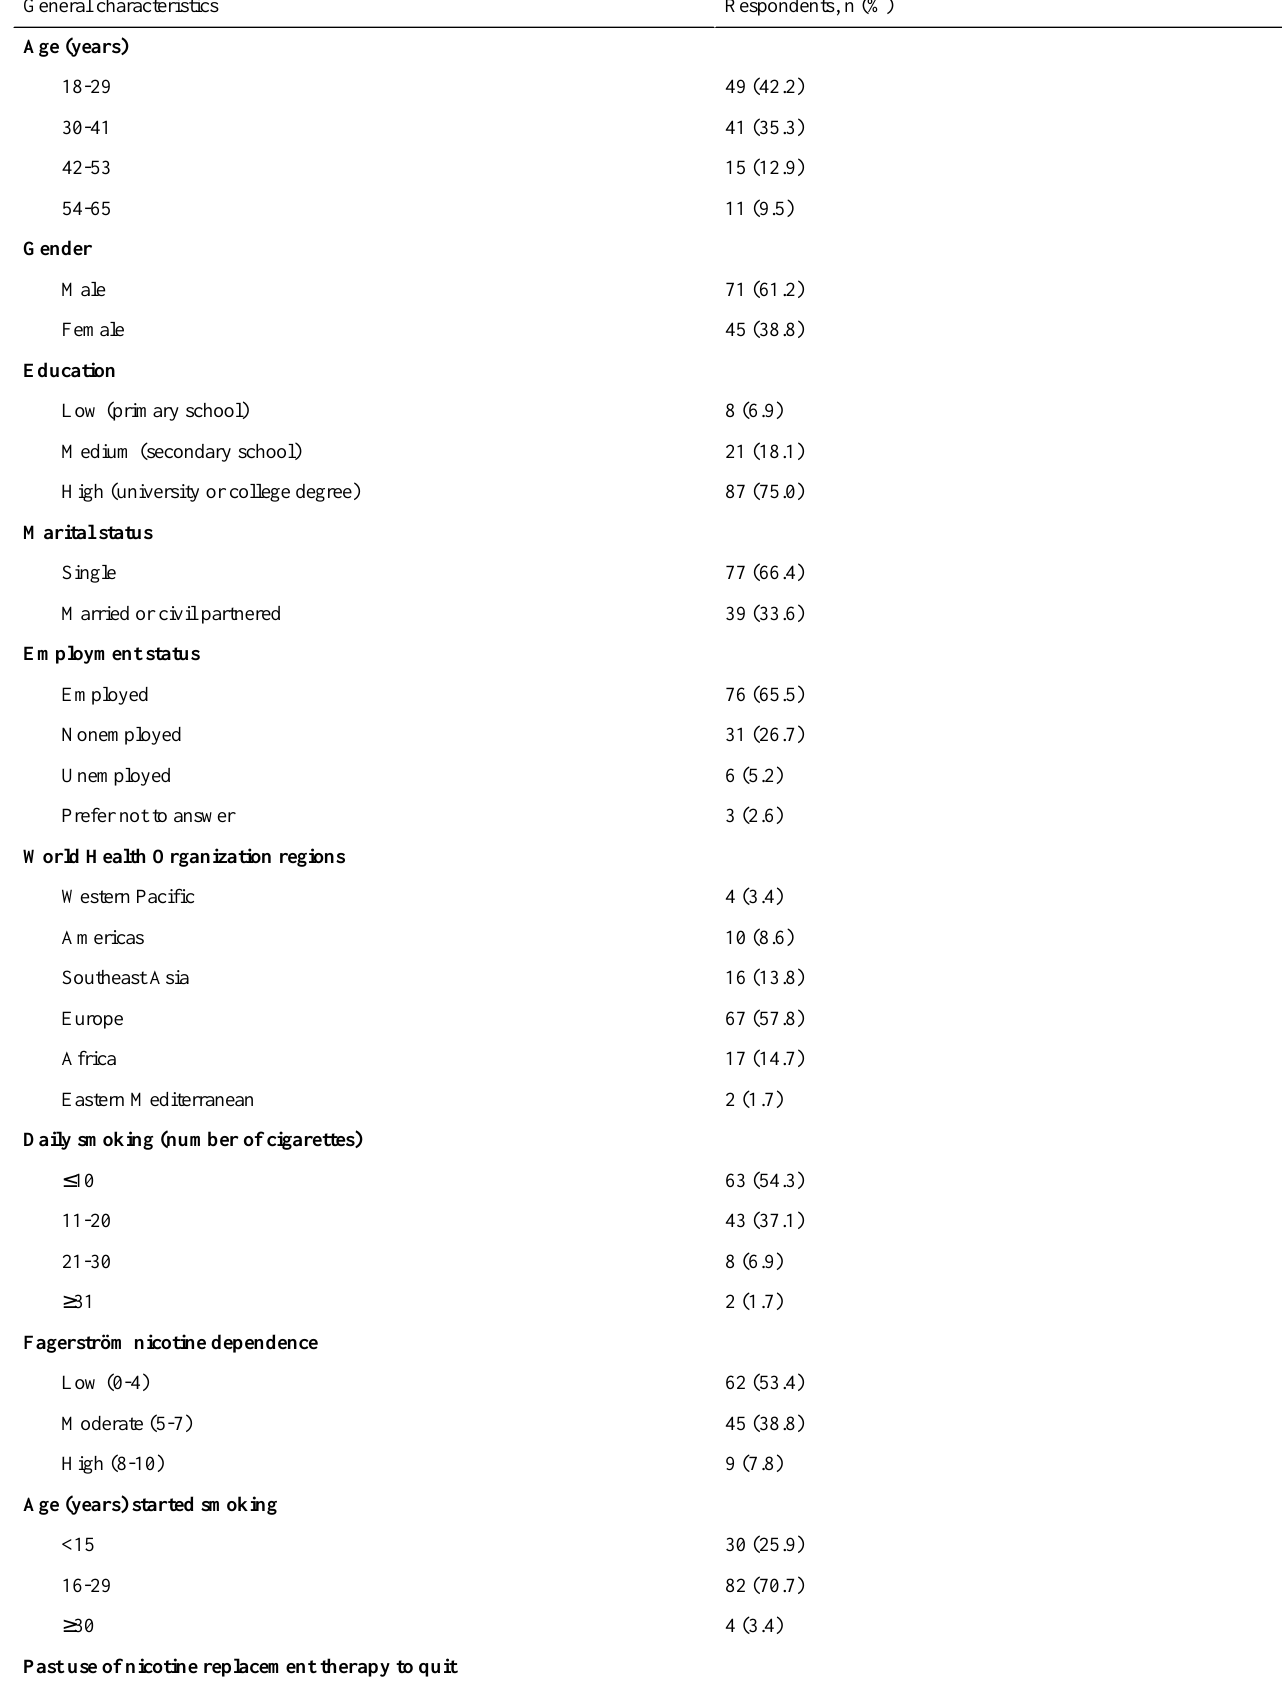
Table 1. General characteristics, smoking habits, and past use of quitting aids